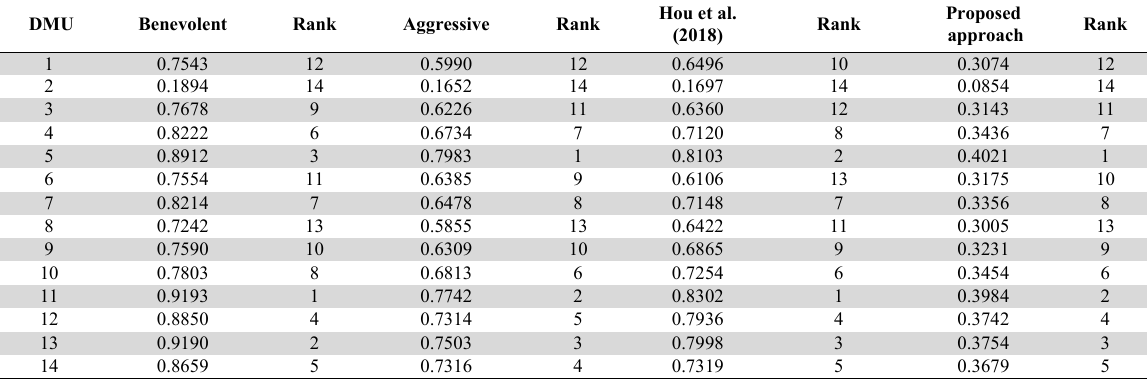
The ranking of each DMU for fourteen international passenger airlines DMU